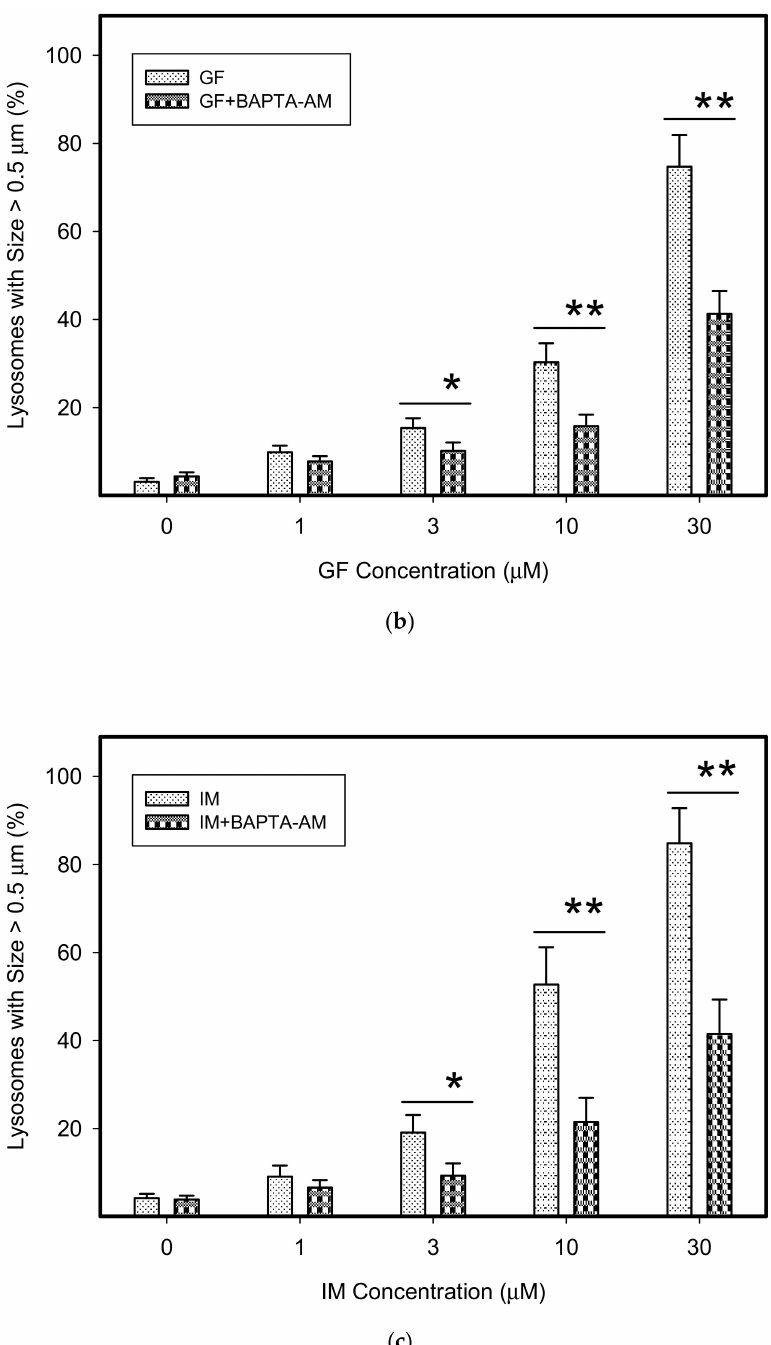
Figure 9. E ff ect of calcium chelator, BABTA-AM, on lysosomal morphology in K562 cells treated with TKIs. Cells were cultured for 6 h in the presence of particular TKI with or without 10 µ M BAPTA-AM under standard conditions and then fixed in paraformaldehyde and subjected to the immunostaining of LAMP1. Cells cultured in medium without TKIs were taken as a control. ( a ) Morphologic changes in lysosomes of K562 cells (typical analysis). ( b ) Quantitative analysis of lysosomal size in GF treated K562 cells. ( c ) Quantitative analysis of lysosomal size in IM treated K562 cells. Lysosomal morphology was evaluated in at least 250 cells for each treatment. The results are shown as means of four independent experiments with standard deviations. * denotes significant change in the number of lysosomes with size > 0.5 µ m ( p < 0.05) between cells treated with TKI and cells treated with TKI + BAPTA-AM. ** denotes significant change in the number of lysosomes with size > 0.5 µ m ( p < 0.01) between cells treated with TKI and cells treated with TKI +